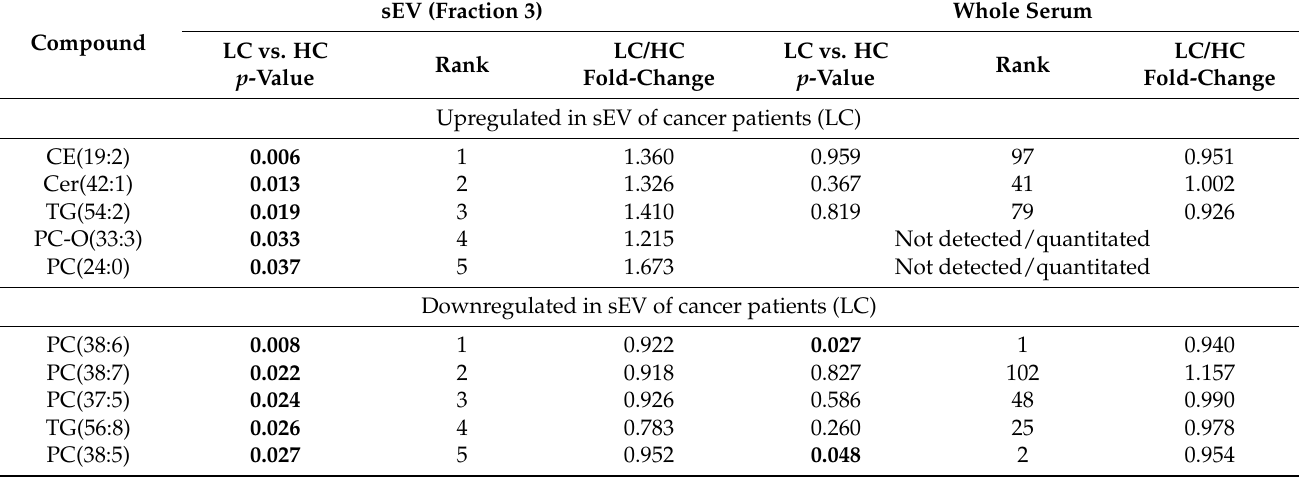
Table 3. Comparison of lipid components in sEV and whole serum. Listed are the top five compounds upregulated and downregulated in sEV from cancer patients; shown is the p -value for LC vs. HC pairwise comparison, the p -value-based rank, and the corresponding LC/HC fold-change (median-based); bold characters reflect statistical